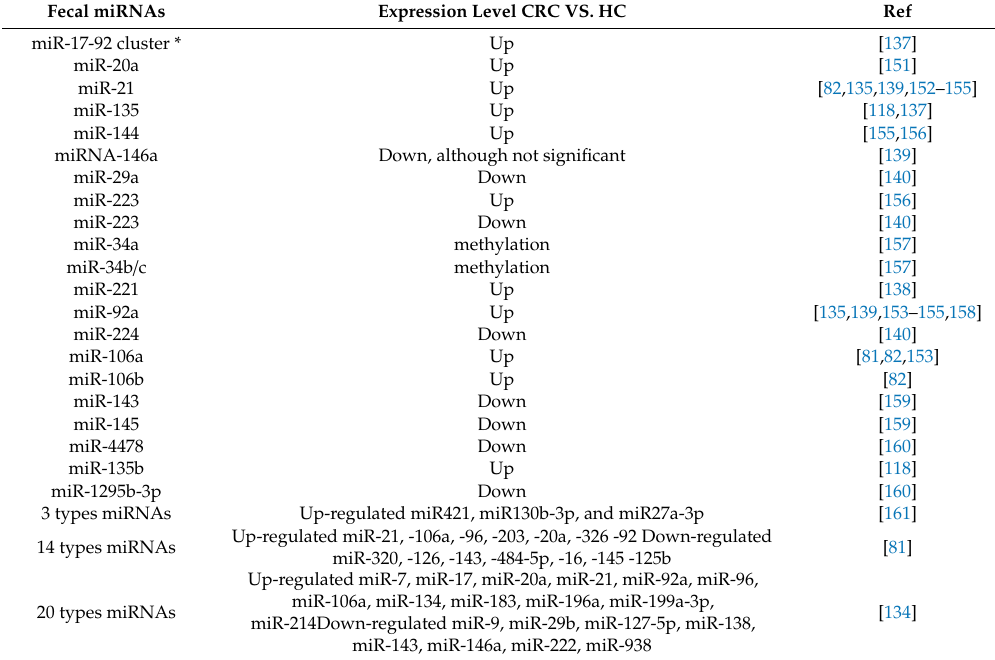
Table 1. Fecal miRNAs as diagnostic biomarkers for colorectal cancer